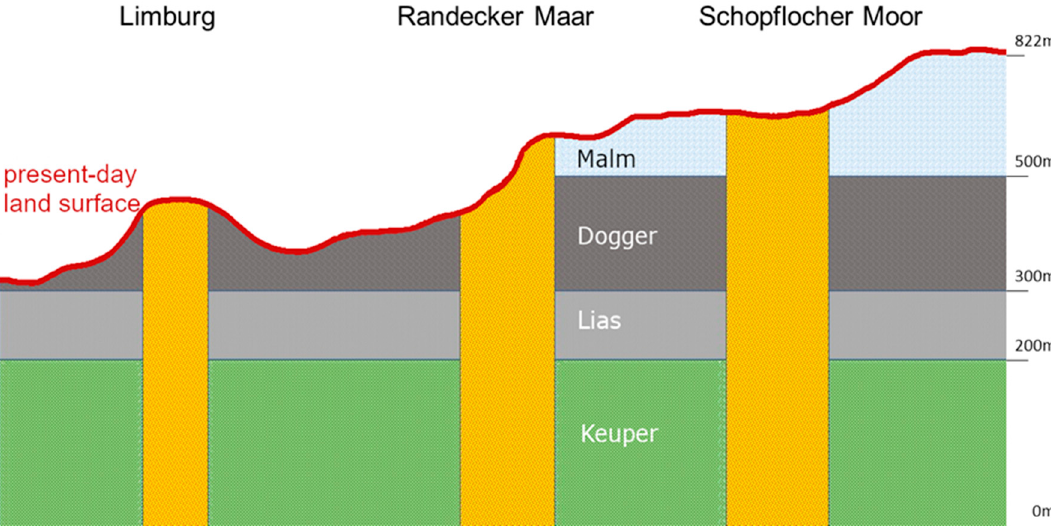
Figure 6. Volcanic vents and erosion (Author’s design, based on [59]).